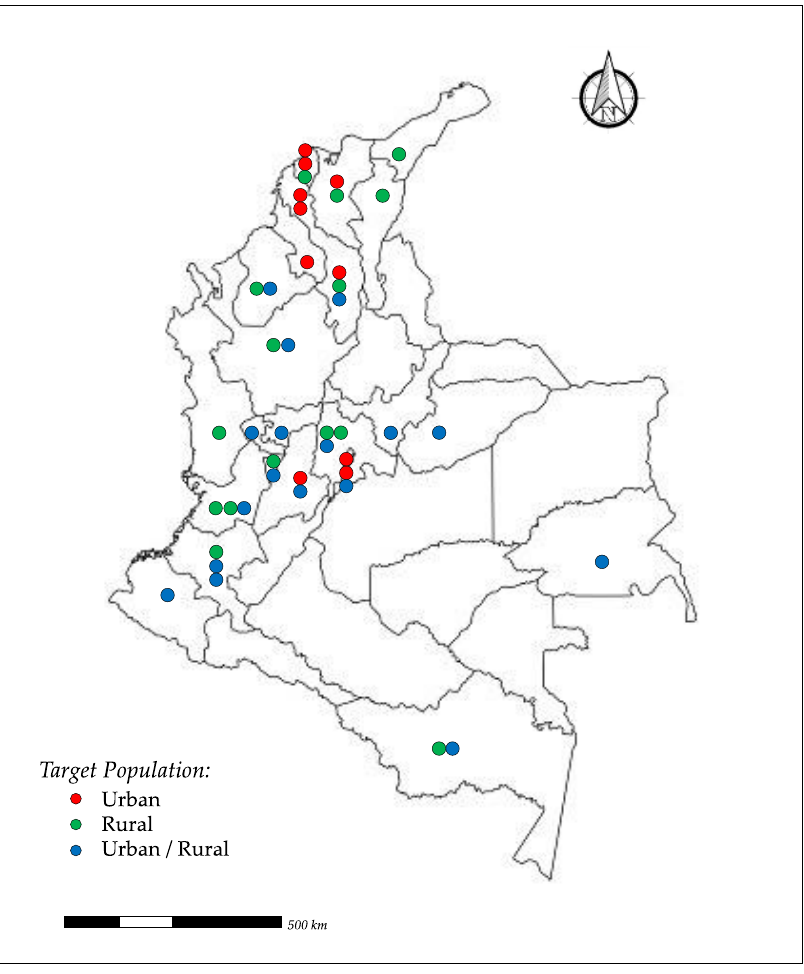
Figure 2. Study areas and target populations.